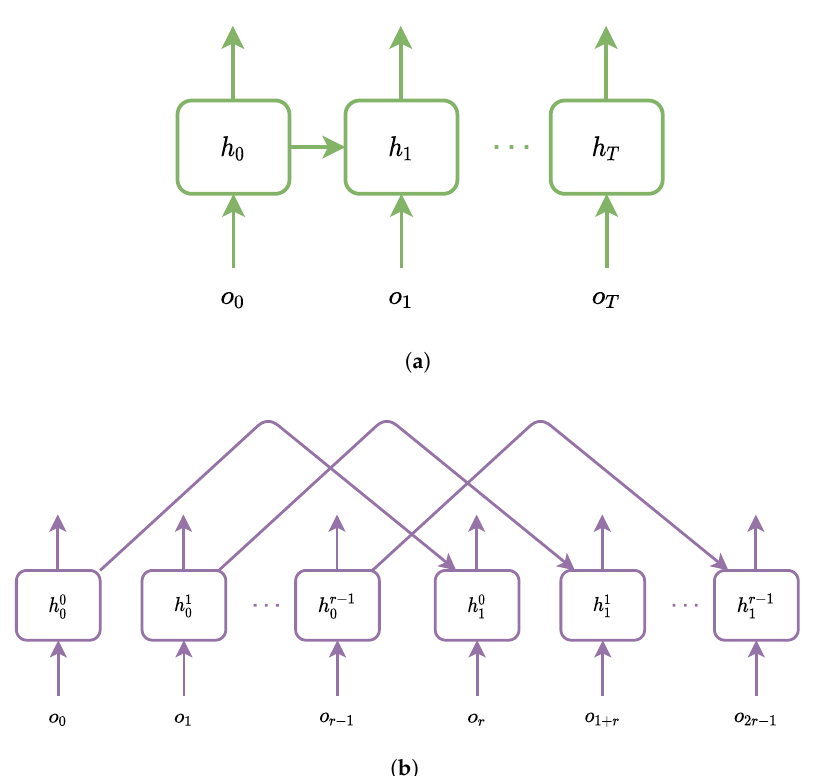
Figure 2. The traditional GRU versus the dilated GRU: ( a ) The unrolling structure of the traditonal GRU; ( b ) The unrolling structure of the dilated GRU.